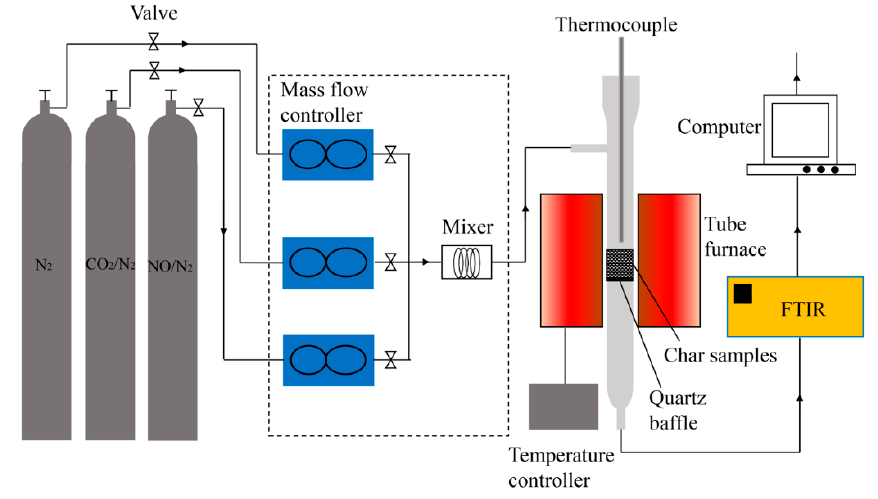
Figure 1. Experimental setup for NO reduction.